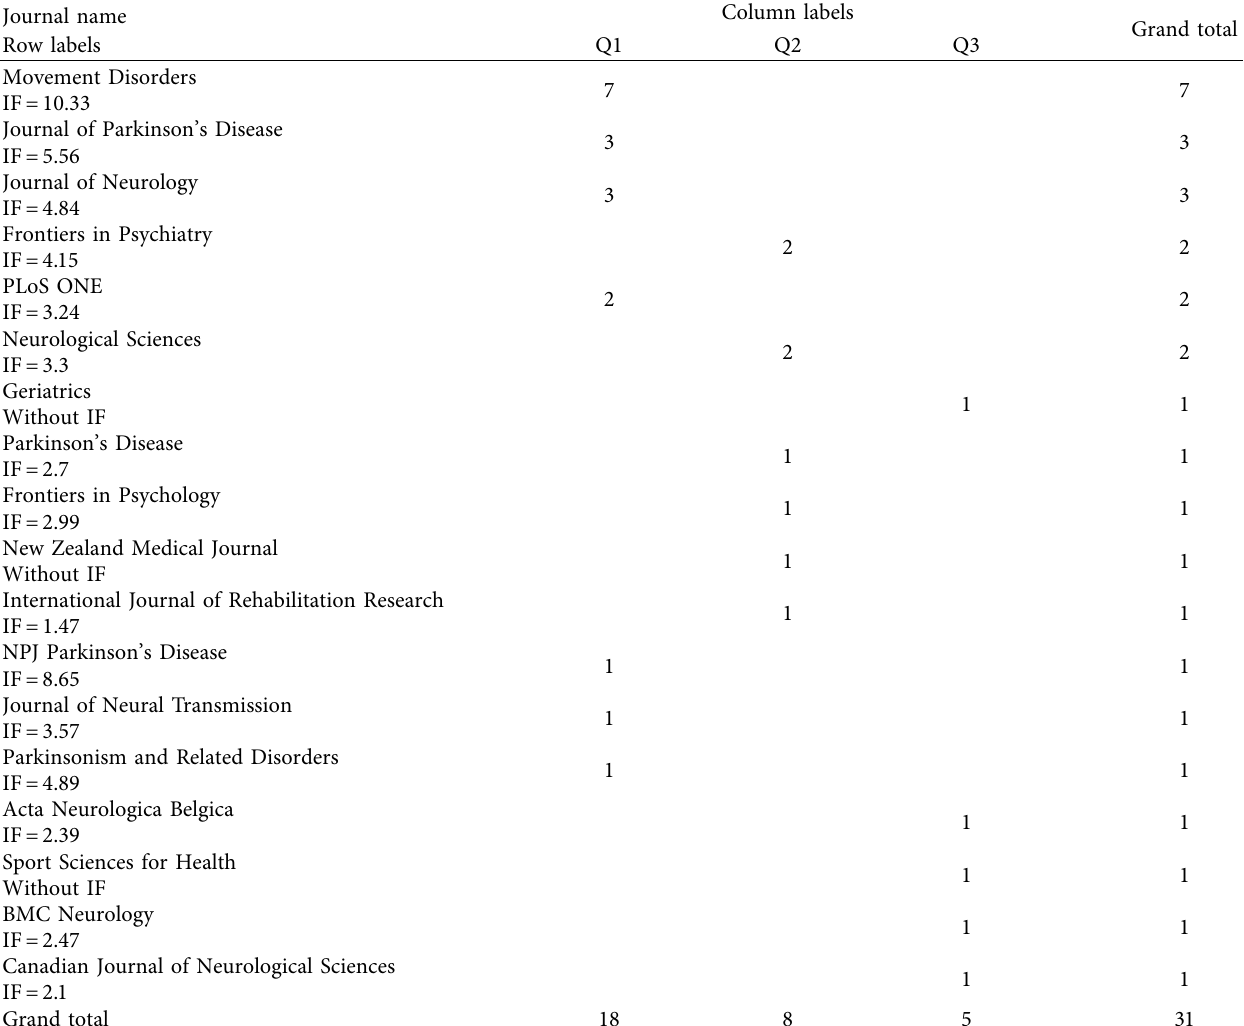
Table 5: Distribution of papers by journals, quartile scores, and IF.